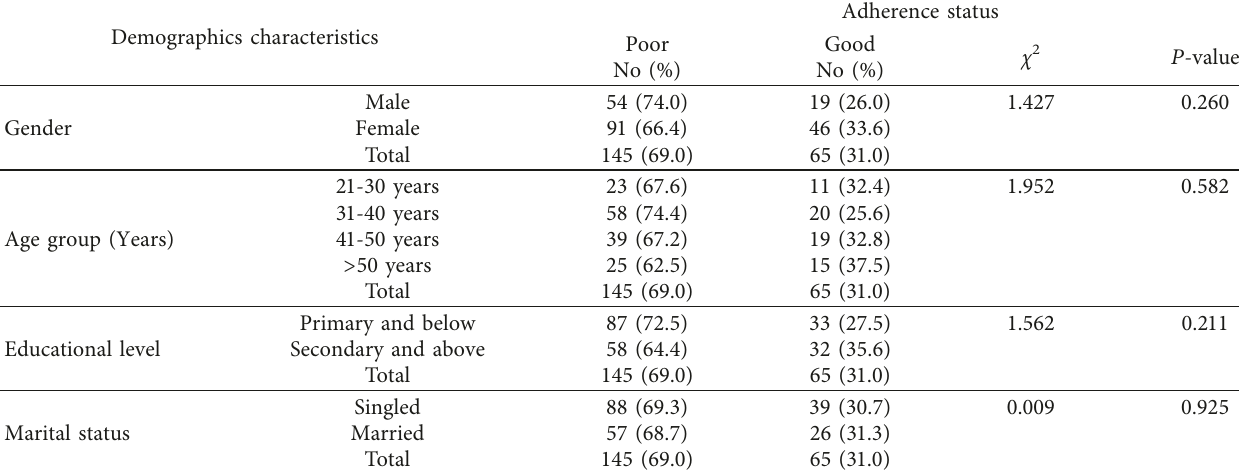
Table 3: Adherence to ART and demographic characteristics among the participants from Buea and Kumba Hospitals.